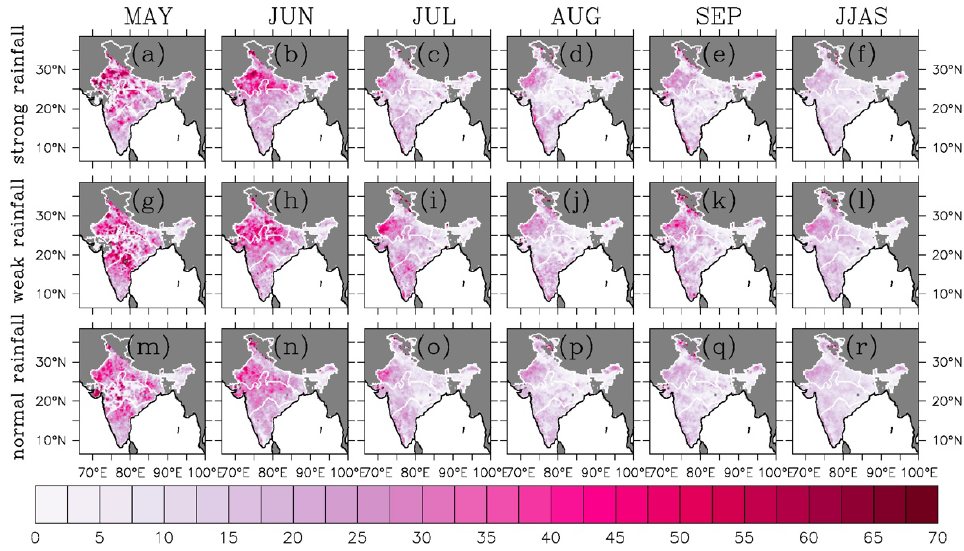
Figure 7. Spatial distribution of explained variance in India based on a linear regression analysis for daily SM regressed on daily rainfall for May through September and JJAS during strong ISMs ( top row , ( a – f )), weak ISMs ( second row , ( g – l )), and normal ISMs ( bottom row , ( m – r )). The linear regression was computed based on the IMD 0.25° daily rainfall grids. The period for analysis is 1992–2020. The borders between the IMD regions are shown in white.